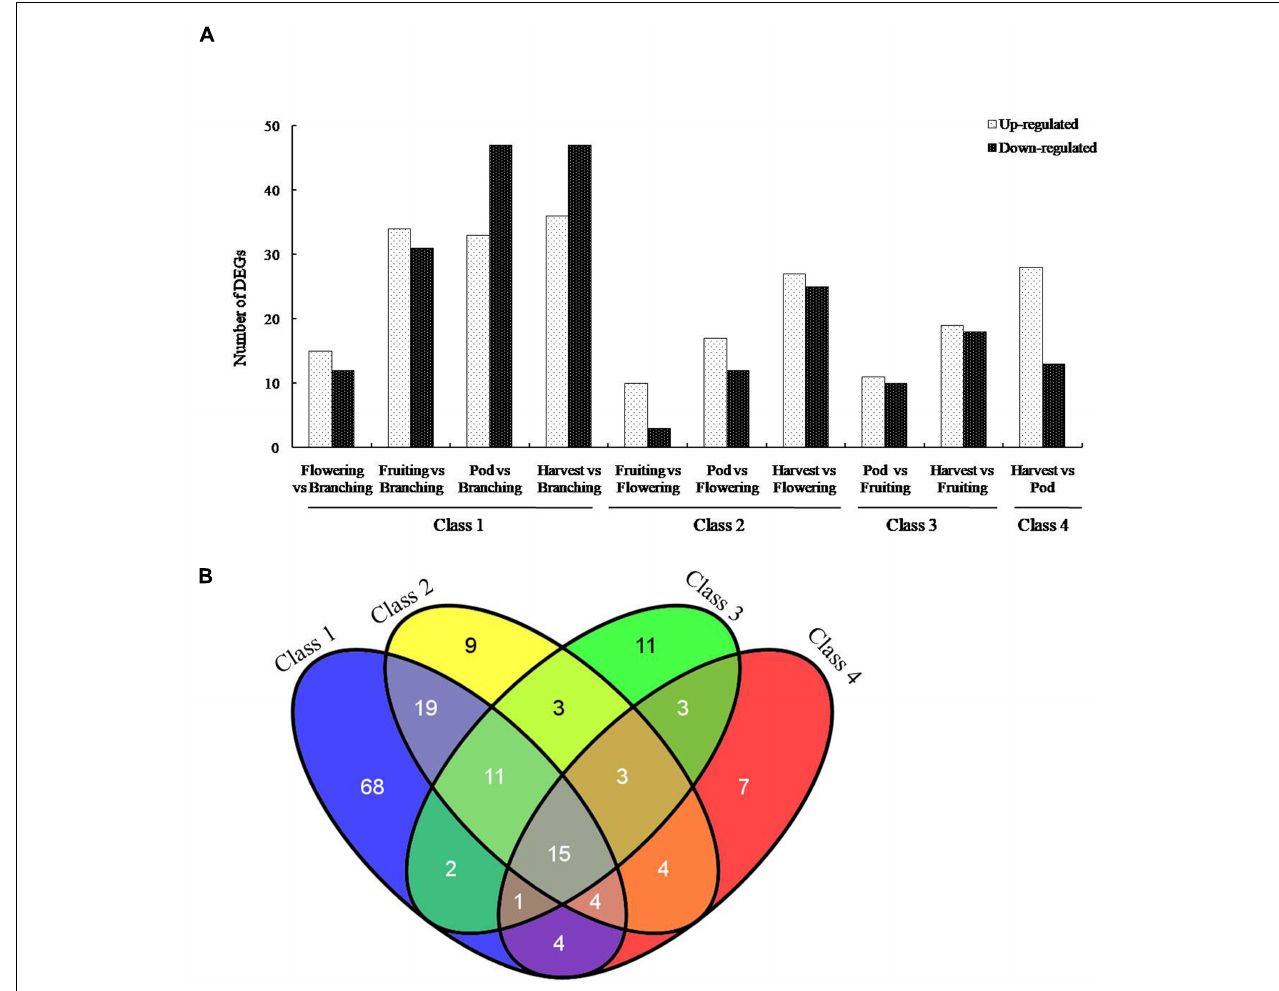
FIGURE 2 | Genes differentially expressed in soybean nodules at five developmental periods of soybean. (A) Differentially expressed genes (DEGs) of B. diazoefficiens 113-2 between different nodule samples from five developmental periods of soybean. These DEGs were separated into two groups according to whether they were significantly up-regulated or down-regulated. Class 1, Flowering vs. Branching ∪ Fruiting vs. Branching ∪ Pod vs. Branching ∪ Harvest vs. Branching. Class 2, Fruiting vs. Flowering ∪ Pod vs. Flowering ∪ Harvest vs. Flowering. Class 3, Pod vs. Fruiting ∪ Harvest vs. Fruiting. Class 4, Harvest vs. Pod. (B) Venn diagrams showing the number of DEGs in each gene set for the four